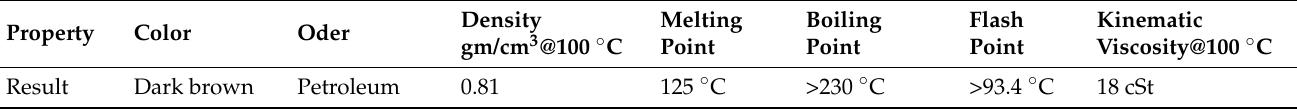
Table 12. Physical characteristics of SonneWarmix RT TM .